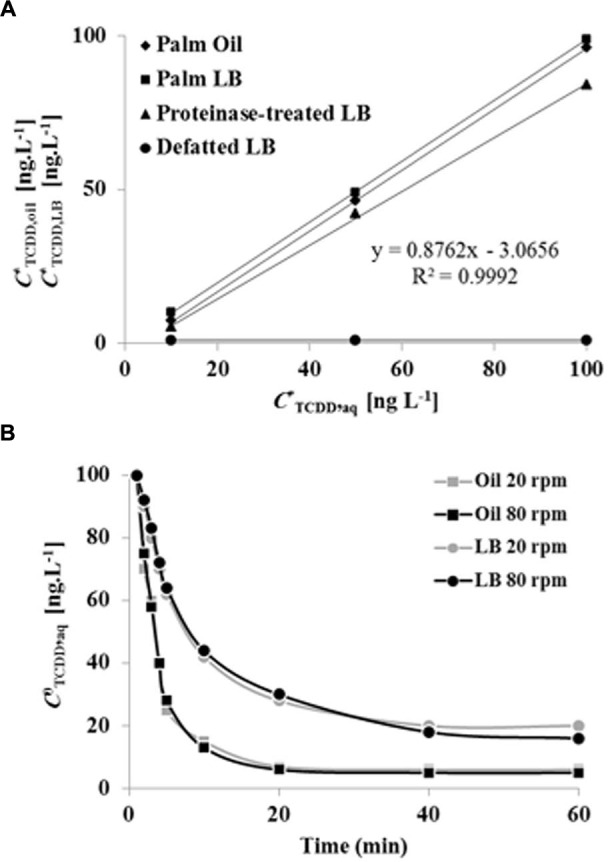
Equilibrium plots and kinetics of TCDD partitioning into palm oil, date palm LDs, proteinase K-treated LDs and defatted LD.
(A) TCDD partitioning into palm oil (rhomboids), date palm LDs (squares), proteinase K-treated LDs (triangles) and defatted LDs (circles). For assays with oil or LDs, the total oil content was fixed at 5% [w/w] for a total volume of 6 mL. For defatted LDs, an equal volume of LDs was defatted with diethylether. The sorption assay was carried out on a rotary shaker at 240 rpm for 60 min in the presence of 0, 10, 50, and 100 ng L-1 TCDD. Extraction and analysis of TCDD was carried out as described in Section “Materials and Methods.” Three separated sorption experiments were performed for each concentration of TCDD and the subsequent analysis of extracted TCDD by HR-GC/MS was done in triplicate. (B) Kinetics of TCDD partitioning in palm oil or date palm LDs with shaking at 20 and 80 rpm. Measurements realized in (82 mm long, 16.8 diameter) rounded end polypropylene tubes, with a total volume in the tube of 6 mL. Three measurements were done for three individual experiments. Data are mean values ± SD (n = 6).